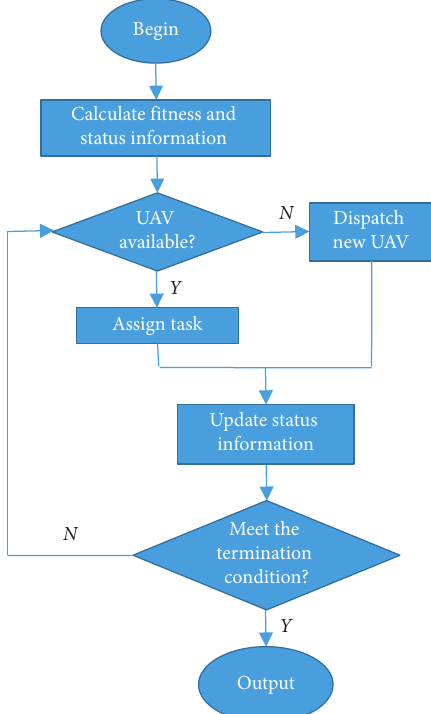
Figure 4: Flow chart of the second task